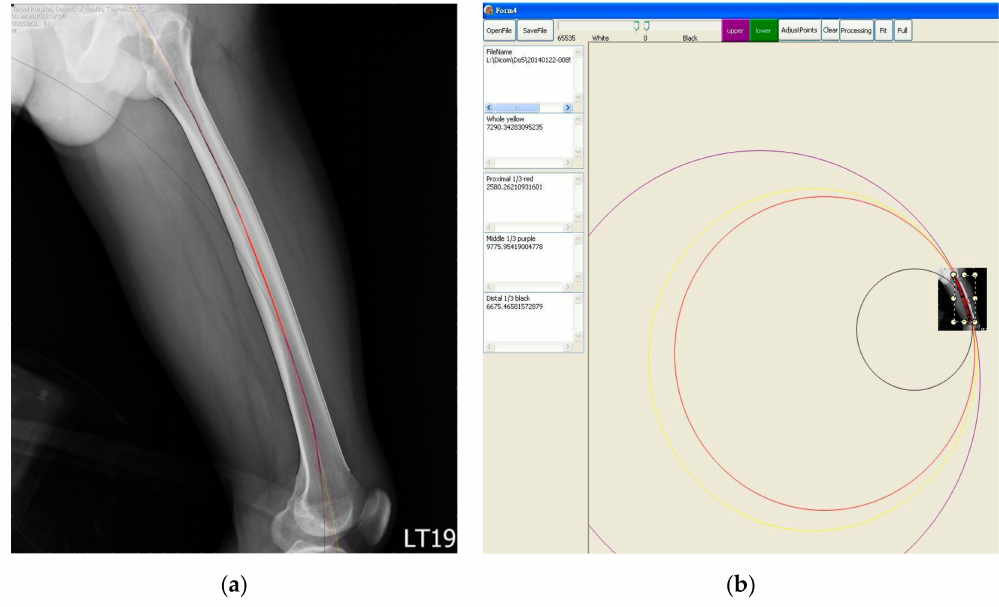
Figure 6. Result screen: zoom in ( a ), zoom out ( b